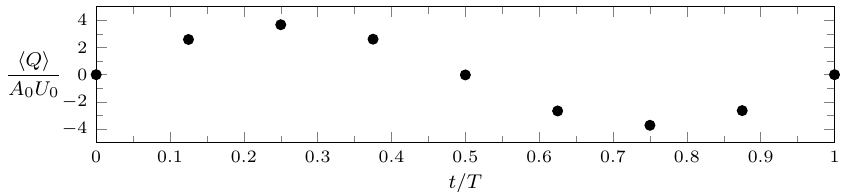
Q issuing from one orifice. (cid:104) (cid:105)